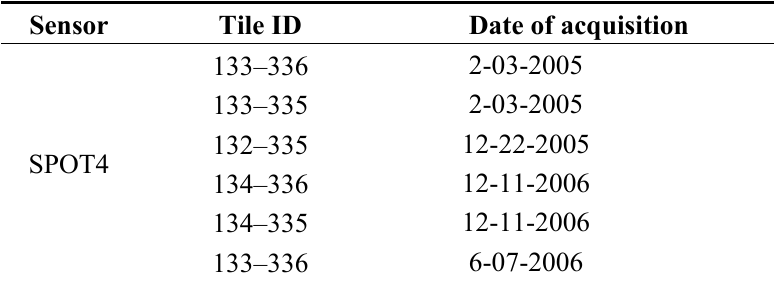
Table A1. The details of SPOT and RapidEye scenes used in this study; the tile IDs of SPOT images are based on the SPOT K-J reference